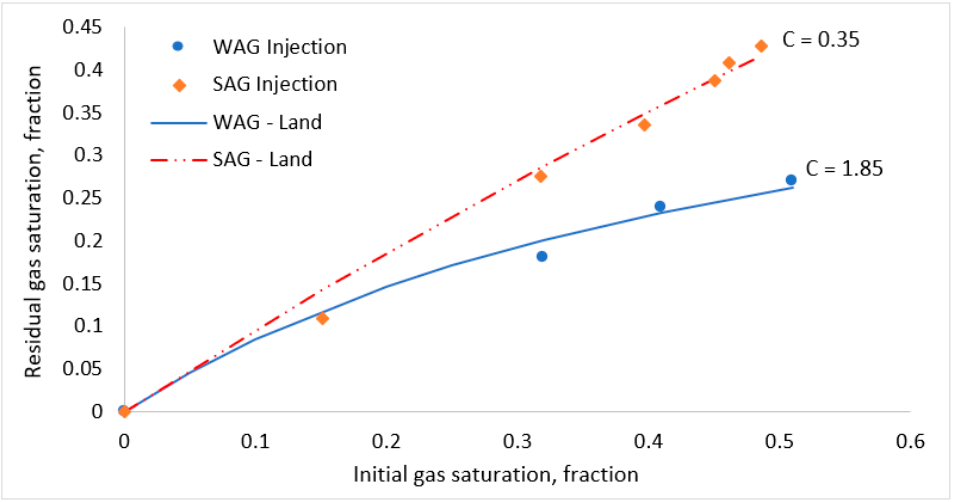
Figure 6. Initial–residual saturation curves of the BH sample under WAG (blue symbols) and SAG injection (orange symbols). The solid and dashed lines show the best-fit Land’s model and the corresponding value of the C coefficients for the WAG and SAG injection process, respectively.